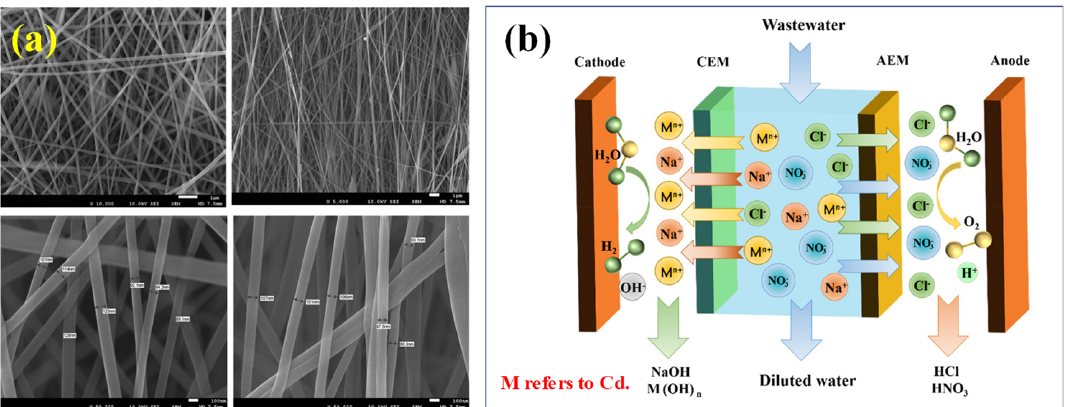
Figure 13. ( a ) SEM image of the PVA/Chi nanofiber membrane, reproduced from [122], with permission from Elsevier, 2018; ( b ) Schematic diagram of the electrodialysis process for heavy metal removal [123], with permission from Elsevier, 2022